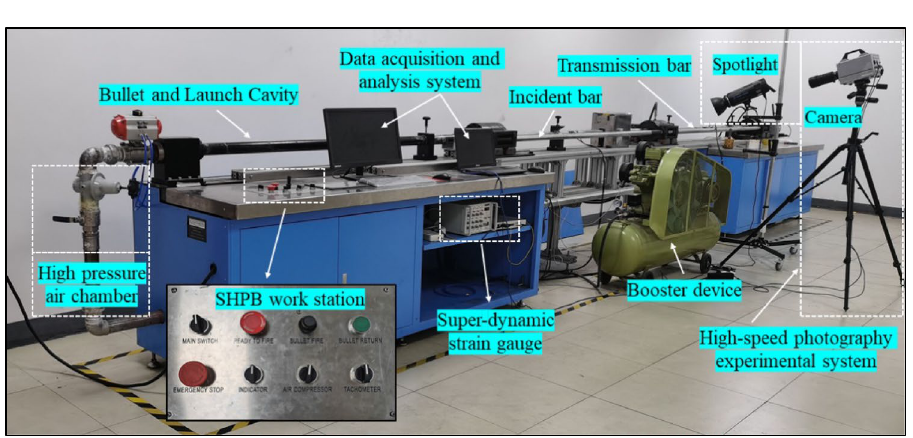
Figure 2. SHPB experimental system used in this paper. ( a ) Schematic view of the SHPB experimental system; ( b ) Physical map of the SHPB experimental